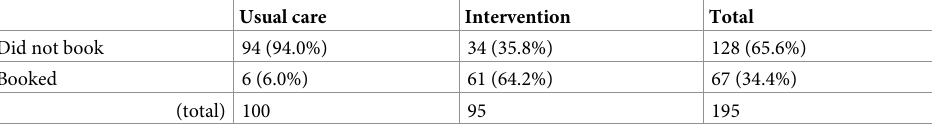
Table 4. Frequency and proportion of booking a screening appointment within 14 days in the phone call trial.